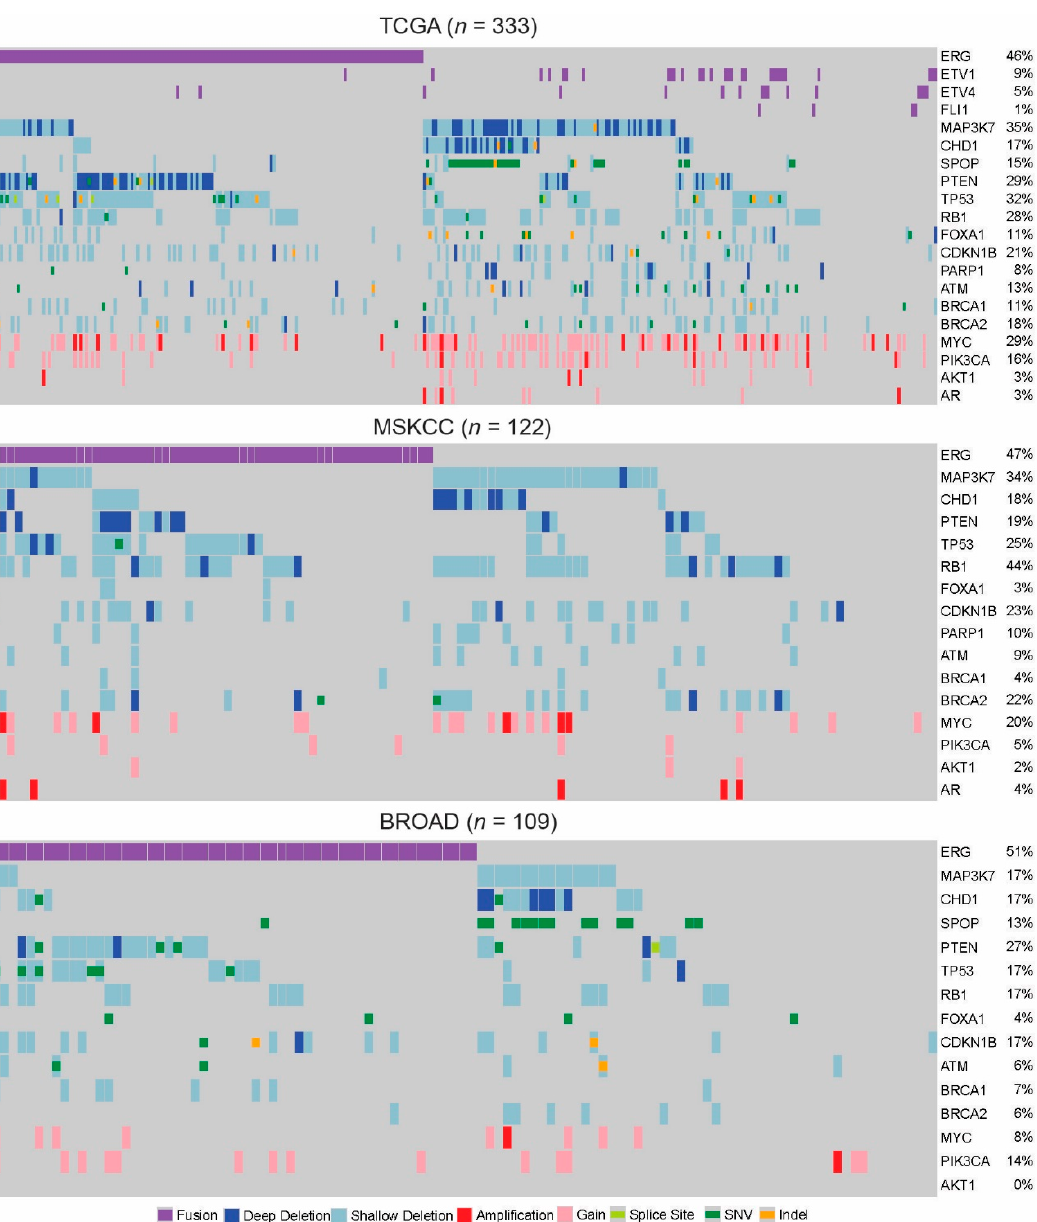
Figure 1. Genomic alterations across multiple primary PCa cohorts. Meta-analysis of three independent cohorts of primary PCa evaluating frequencies of the most common genomic alterations at this disease stage: TCGA [21], MSKCC [15], and BROAD [22]. The MSKCC dataset had few samples with mutation data, so mutational frequencies are underrepresented in this cohort. Shallow and deep deletions indicate heterozygous and homozygous deletions, respectively. Gain and amplification indicate low-level and high-level copy gain, respectively. Calls for alterations are based on algorithms used and parameters set within each cohort’s data